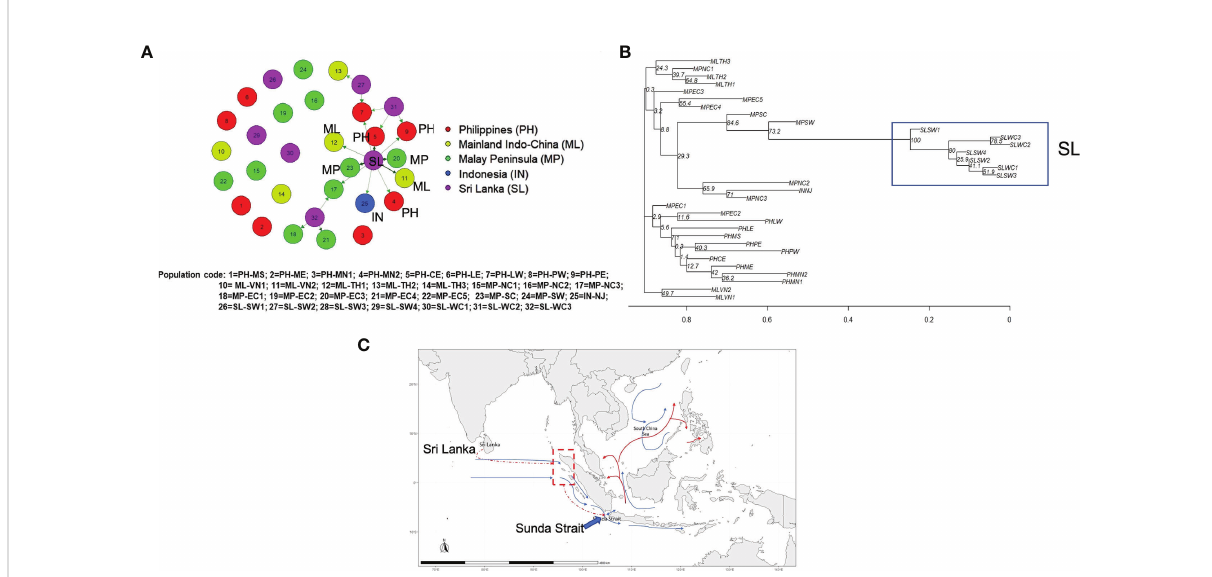
FIGURE 7 Migration and phylogeny of nipa populations in IWP. (A) The contemporary migration patterns of nipa populations in the Indo-West Paci fi c using the divMigrate function of diveRsity, an R statistical package, for the signi fi cant relative migration based on Nm using fi lter threshold at 0.12 for asymmetric values (bold and dark arrows have higher migration values than light colored arrows) (bootstrap = 1000). (B) Phylogenetic tree constructed with 18 microsatellite loci using the neighbor-joining (NJ) method (bootstrap = 1000). (C) The hypothesized migration pattern from Sri Lanka (dashed red arrow) via the hypothetical route to northwestern Sumatra nipa populations (red dashed line and dash-lined box) by long- distance dispersal to Southeast Asia through Sunda Strait as labeled accordingly. The blue arrow lines indicate the predominant surface current during the Southwest Monsoon (Schott and McCreary, 2001; Han et al., 2009; Wang and Li, 2009; Susanto et al., 2016) and the red arrows indicate the signi fi cantly strong patterns in migration network